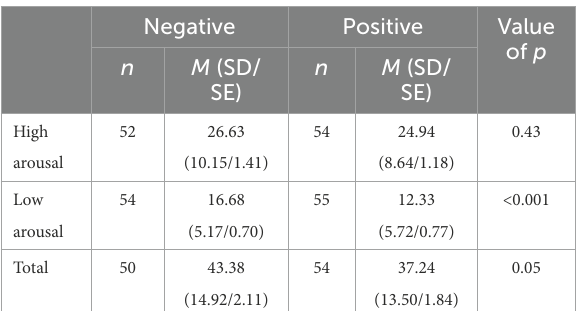
TABLE 4 Positive, negative, activated and deactivated affect among non-binary adolescents. Negative Positive Value